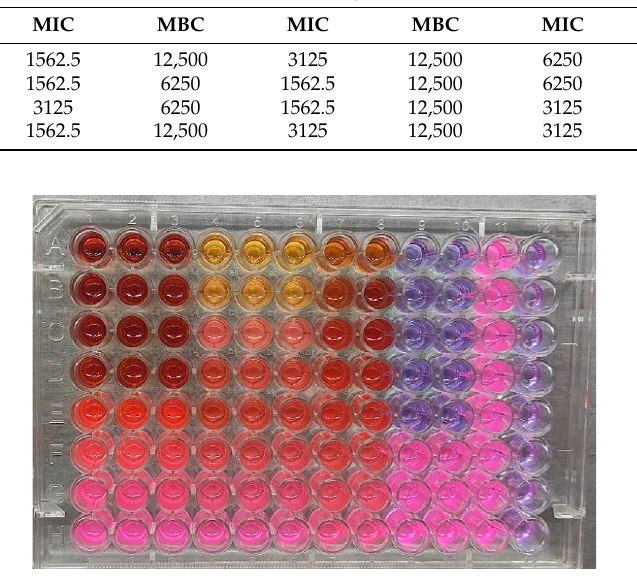
Figure 3. MIC of different extracts and antibiotics against E. coli : 1–3: B. ciliata (A–H: